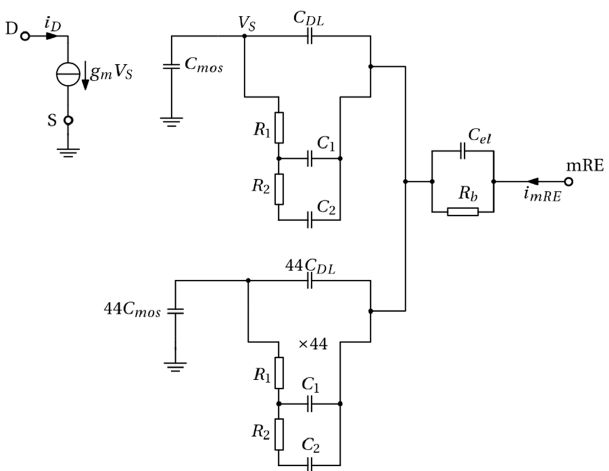
Figure 7. Complete circuit model of one active ISFET (top left portion) and 44 unbiased ones (source and drain floating, but substrate grounded) in parallel (bottom left). The equivalent circuit model of the surface impedance, due to the SB reactions is given by a two-cell network consisting of R 1 , R 2 , C 1 and C 2 lumped elements (see Figure 6b). The bulk of the electrolyte is represented by the parallel between C el and R b , whereas the mRE is assumed ideal. The node V S indicates the sensing layer of the active ISFET. The simulation includes the thermal noise of resistors of R b and of R 1 and R 2 as indicated in Figure